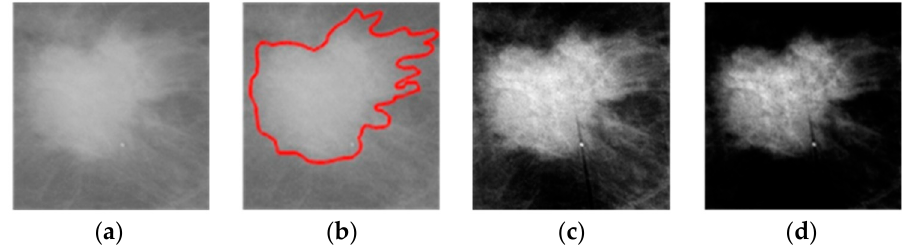
Figure 5. ( a ) Original ROI; ( b ) AD area marked by expert; ( c ) pre-processing result; ( d ) NSCT processing result.